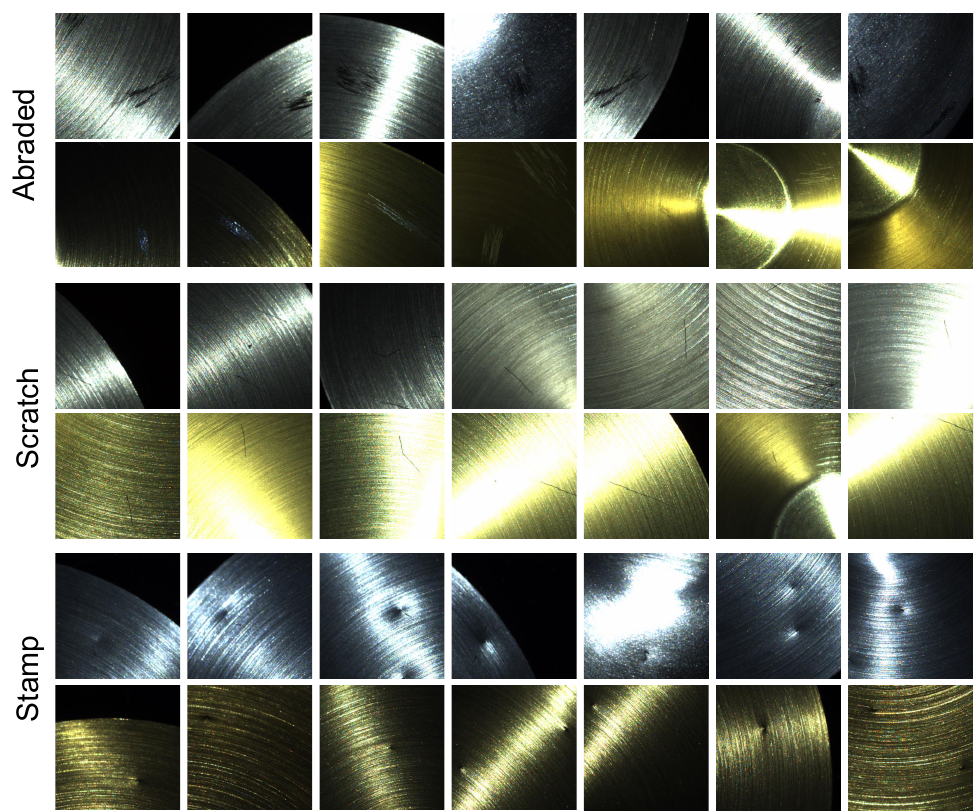
Figure 7. Diagram of the defects. Our dataset contains three types of defects. Rows 1 and 2 are samples of abraded defects. The abraded defects occur in patches and are irregular in shape. Rows 3 and 4 are samples of scratch. The scratches appear individually and are narrow and long. Rows 5 and 6 are samples of the stamp. Stamps usually appear to be circular, with a significant variation in